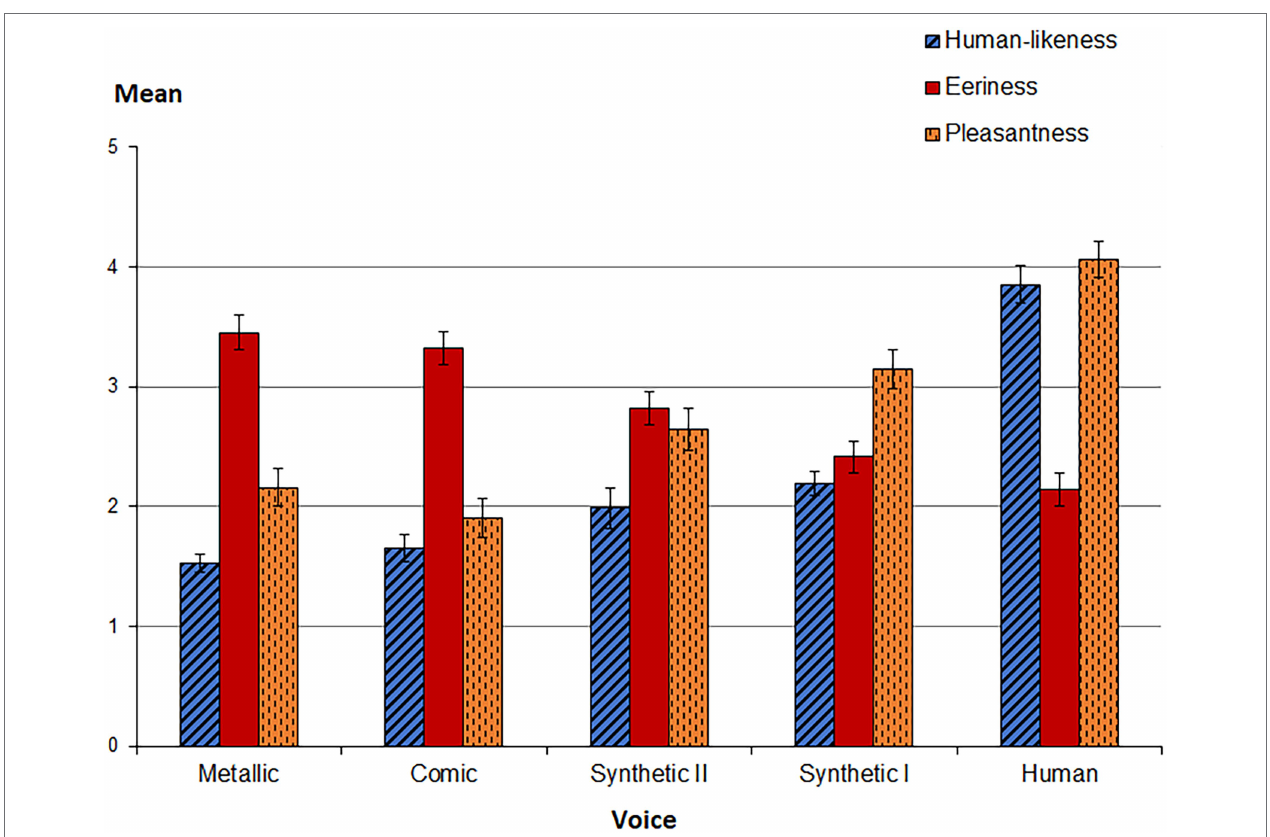
FIGURE 1 | The bar chart shows the mean values of the variables Human-likeness , Eeriness, and Pleasantness depending on the heard voice. The five voices are arranged from left to right in an increasing degree of